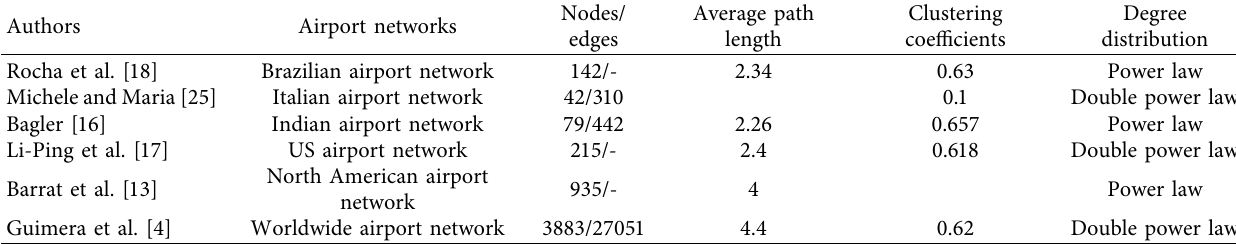
Table 1: Structural properties of airport network worldwide.